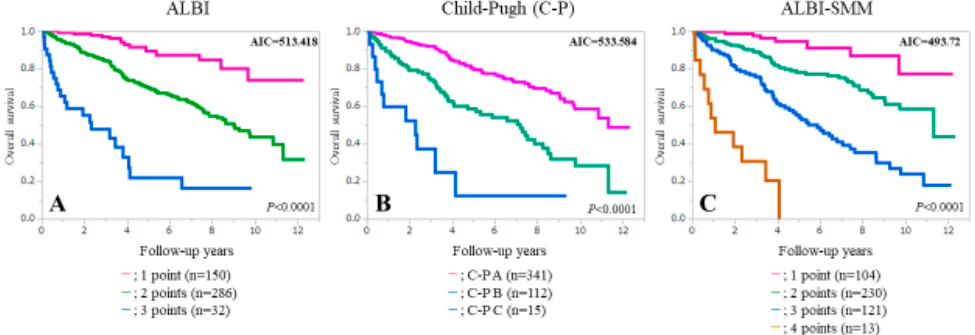
Figure 3. Kaplan-Meier curves according to the ALBI grade ( A ), the Child-Pugh classification ( B ) and the ALBI-SMM grade ( C